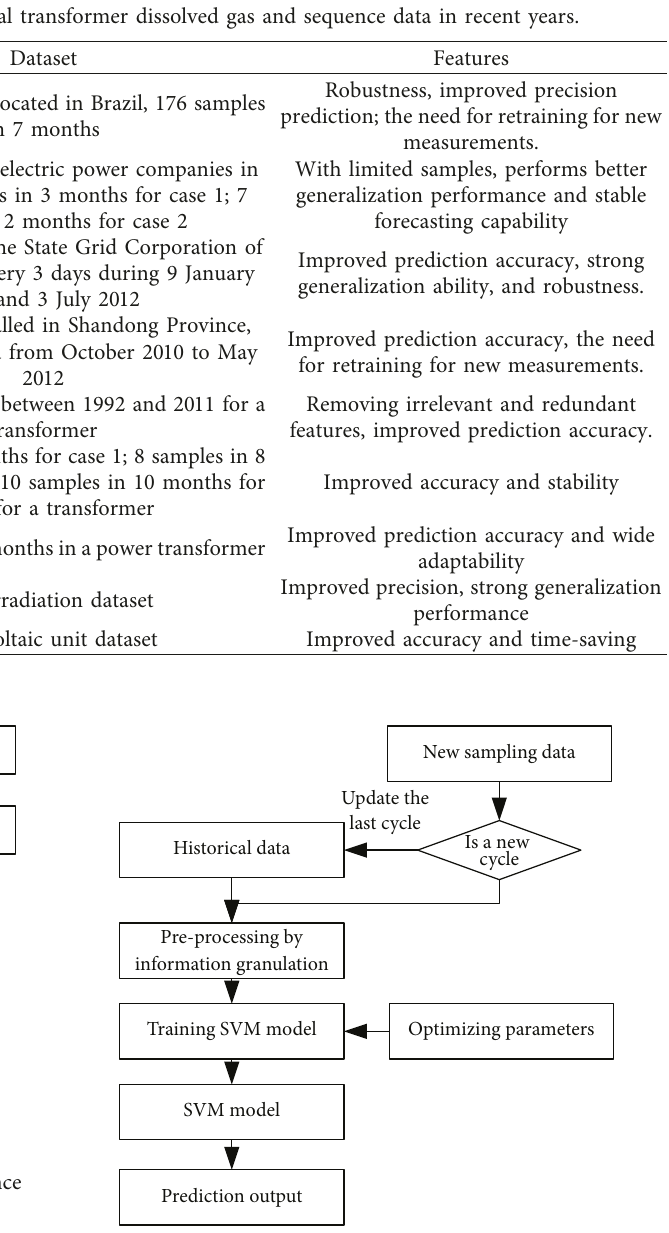
Figure 2: Information granulated SVM-based condition predic- tion